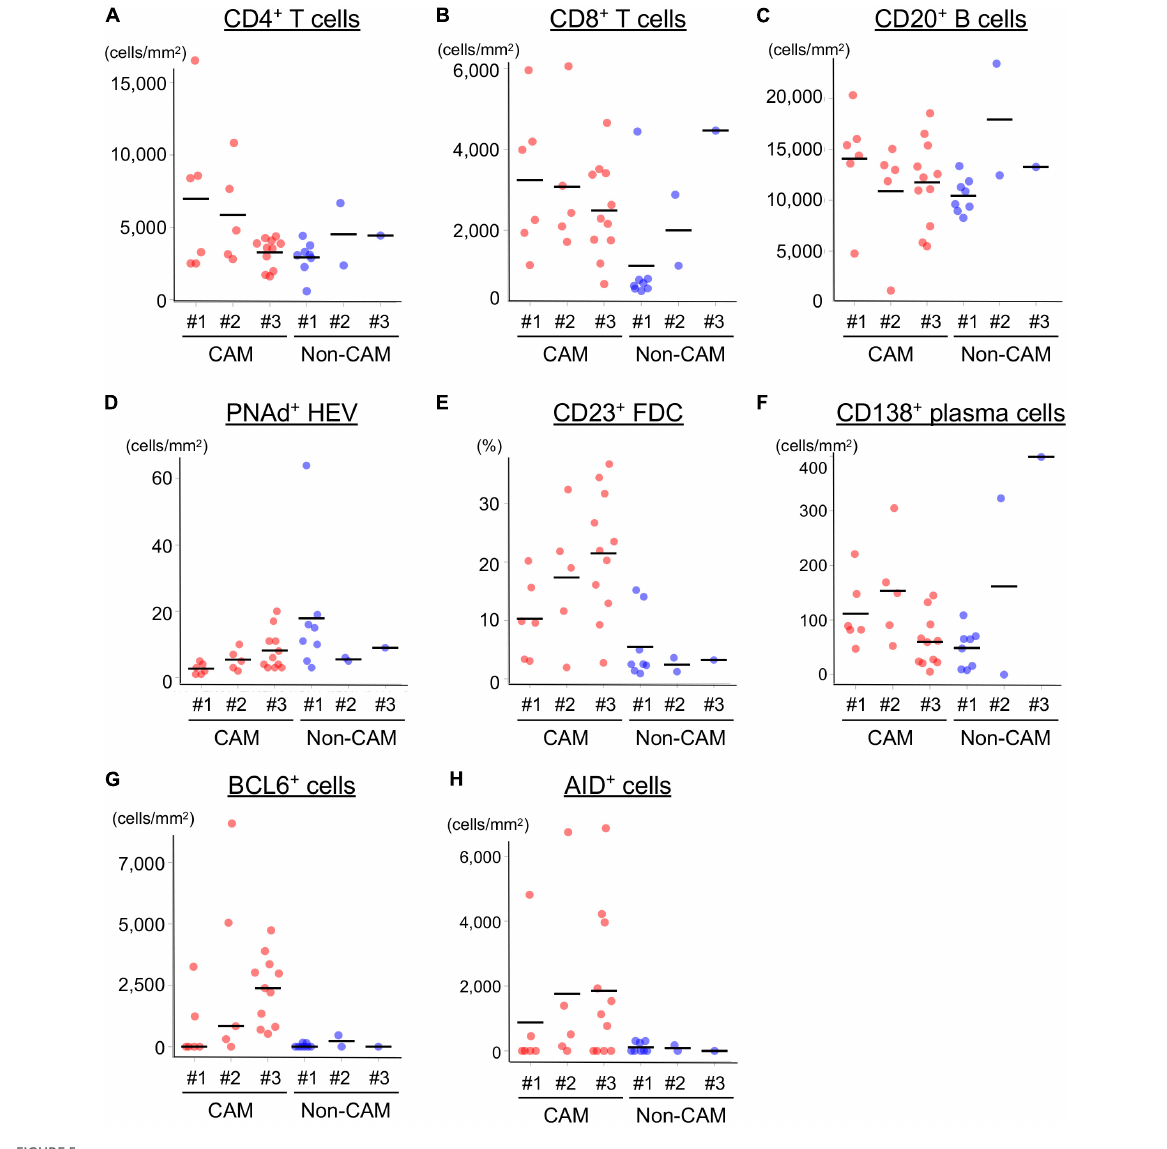
FIGURE5 Density of immune cell components in TLSs from CAM patients and non-CAM controls. The density of CD4 + T cells (A) , CD8 + T cells (B) , CD20 + B cells (C) , PNAd + HEV (D) , CD23 + FDCs (E) , CD138 + plasma cells (F) , BCL6 + cells (G) , and AID + cells (H) in TLSs from 3 CAM patients and 3 non-CAM controls was analyzed by computerized quantitative assessment using the bioimage analysis software QuPath. The horizontal lines indicate the mean. TLSs, tertiary lymphoid structures; CAM, cancer-associated myositis; PNAd, peripheral node addressin; HEV, high endothelial venules; FDCs, follicular dendric cells; BCL6, B-cell lymphoma 6; AID, activation induced